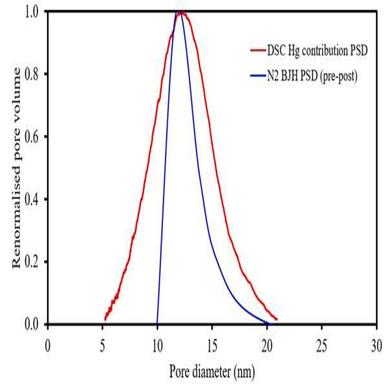
Comparison of the DSC thermoporometry PSD for the void space in G1 occupied by entrapped mercury following porosimetry, with the PSD for that same void space estimated from the difference in the BJH PSDs (using k = 1 in obtained from nitrogen adsorption isotherms measured before and after mercury porosimetry.